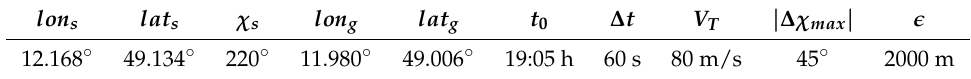
Table 20 lists the values used for the simulation of an automatic holding pattern. Table 20. Index s stands for start state and index g for the goal